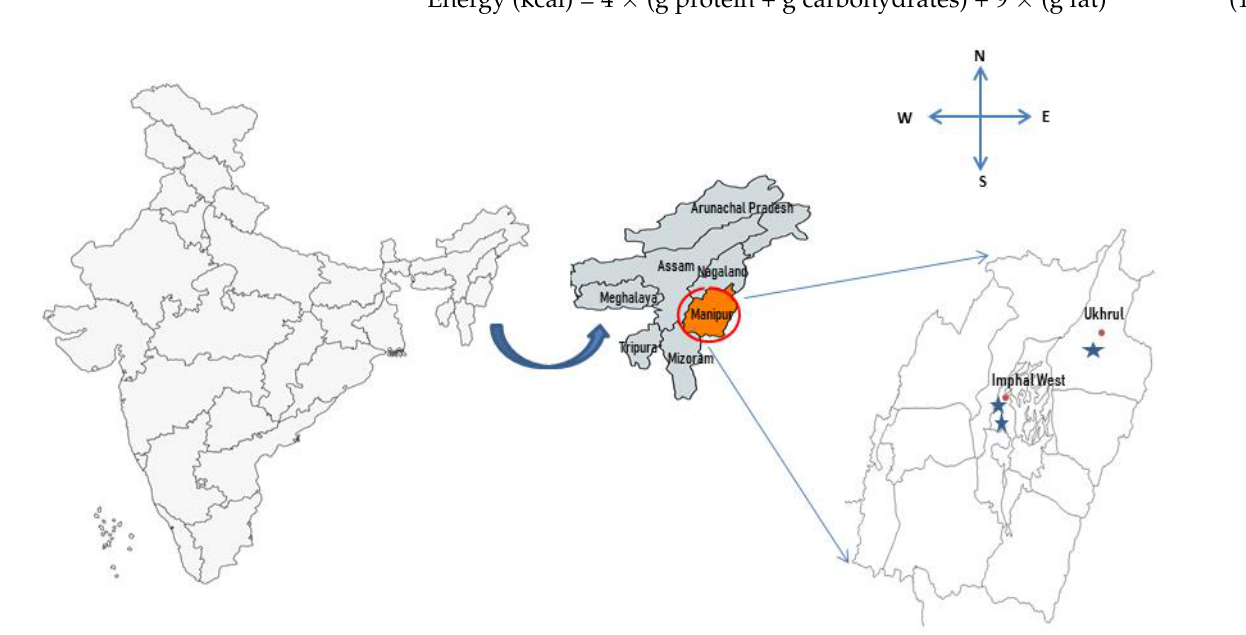
Figure 3. Collection sites of the wild edible mushrooms in Manipur.